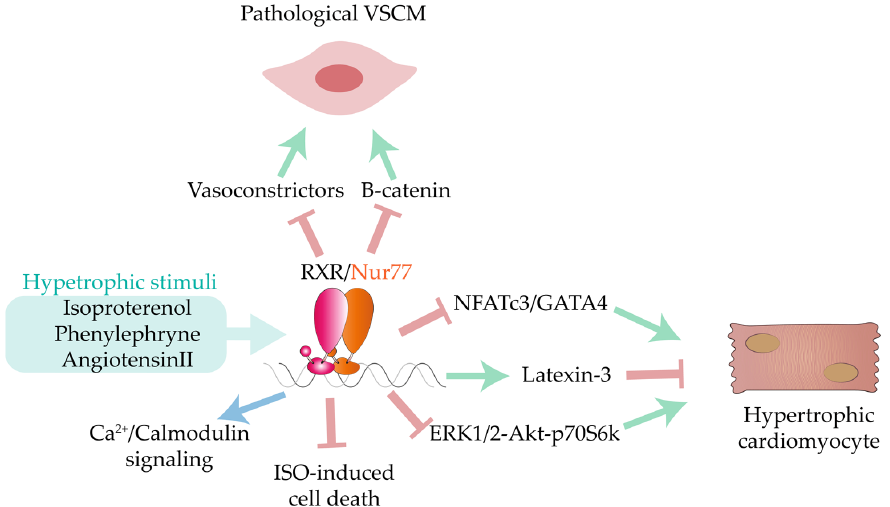
Figure 8. Nur77 anti-hypertrophic functions. Schematic representation of Nur77/RXR modulation during pathological hypertrophy. Inductive signals for Nur77 in this setting are also depicted. Green arrows denote induction. Red arrows denote inhibition. Blue arrows denote homeostatic regulation. RXR, retinoid X receptor. ISO, isoproterenol. ERK1/2, extracellular signal-regulated kinase 1/2. Akt, Protein kinase B. p70S6K, Ribosomal protein S6 kinase beta-1. NFATc3, Nuclear Factor of Activated T Cells 3. GATA4, Transcription Factor GATA-4.